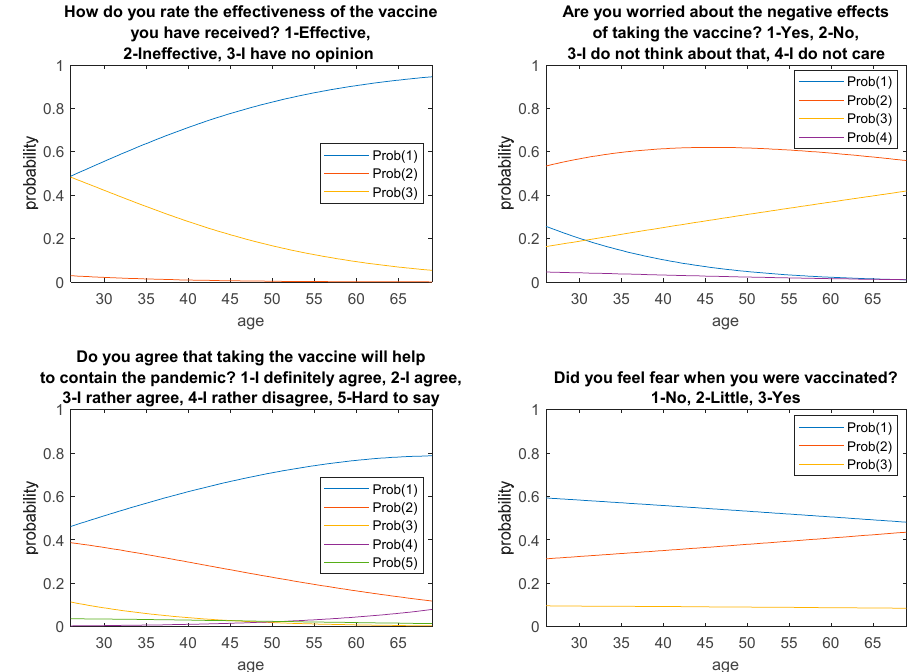
Figure 1. Probability distributions obtained from logistic regression concerning respondents’ answers depending on age.